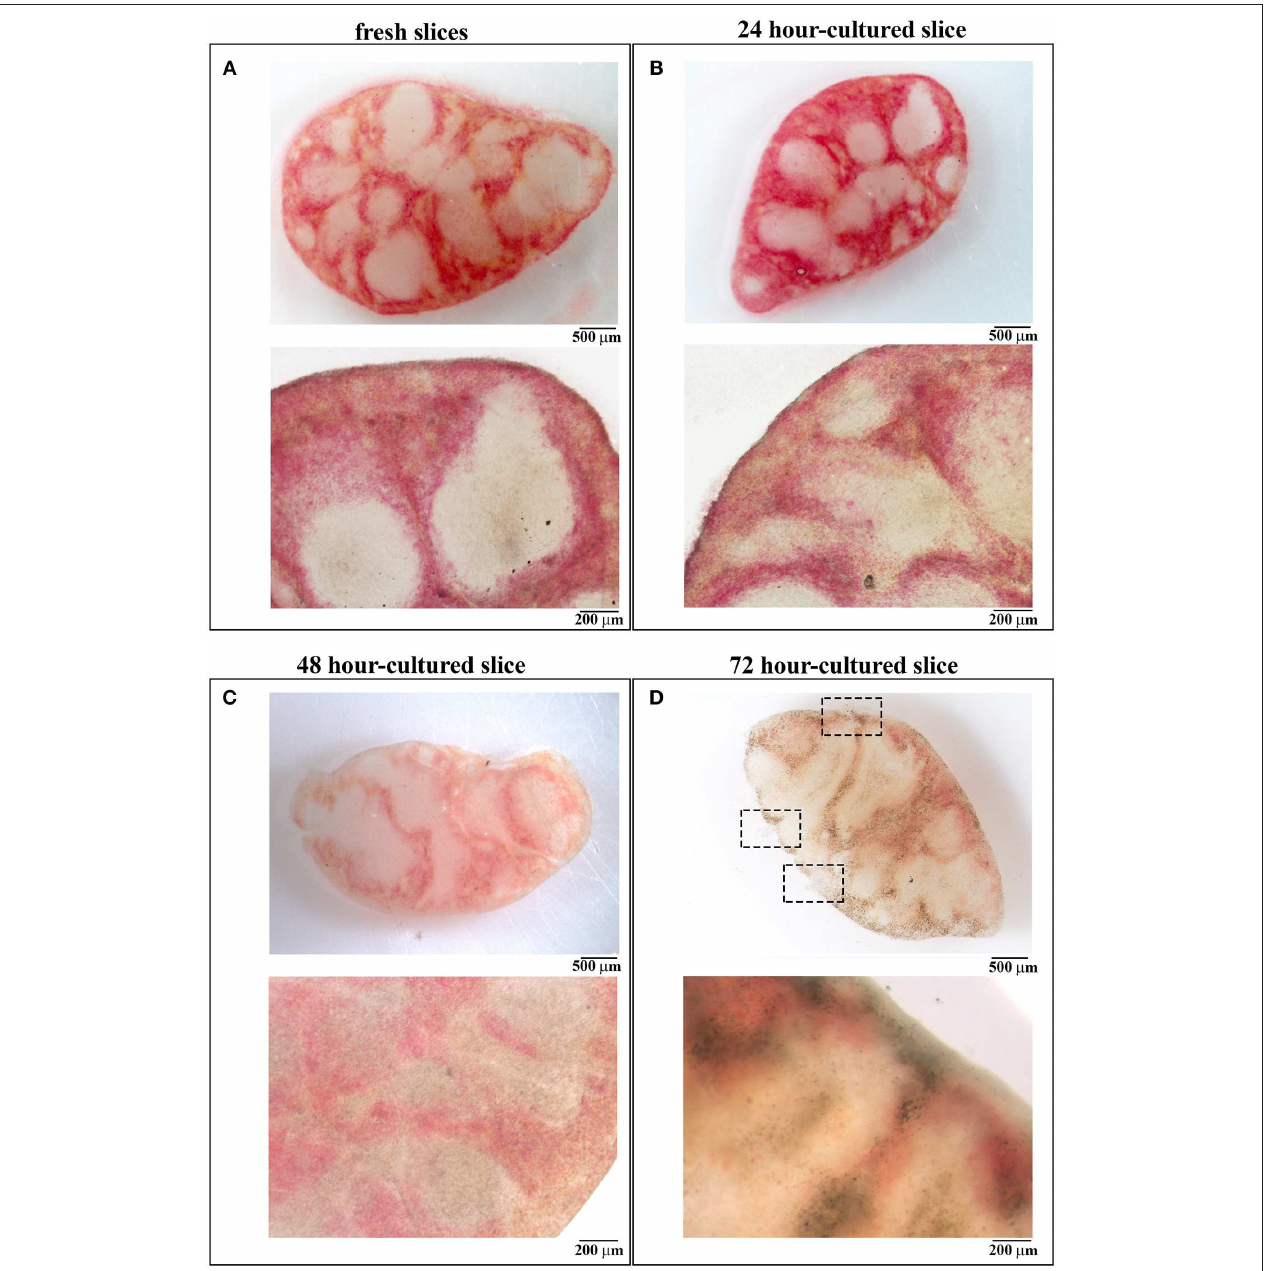
FIGURE 2 | 48 h-cultured spleen slices maintain unaltered their architecture. (A–D) Images obtained by stereomicroscopy (upper panels) and optical microscopy (lower panels) of spleen slices either immediately after cutting (A) or after in vitro culture for 24 (B) , 48 (C) , and 72 (D) hours. Representative images are shown ( n = 3). Size bars are